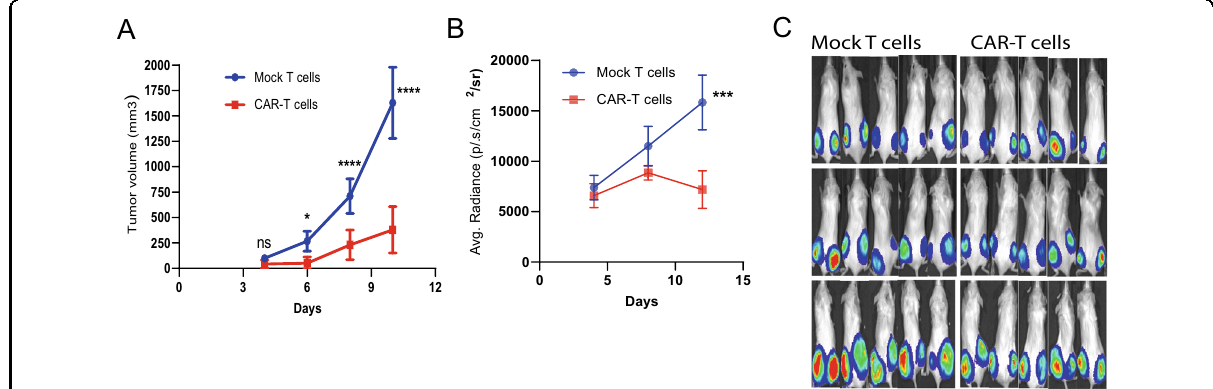
Fig. 5 CD126-targeted CAR-T cells demonstrated potent antitumor activity in murine models of multiple myeloma and prostate cancer. NSG mice were injected subcutaneously with RPMI-ultrachilli-luciferase cells and treated with a single dose of CAR-T cells or mock T cells. a Tumor volume was measured with calipers ( n = 10 each group). b Tumor burden ( D -luciferin BLI of RPMI-ultrachilli-luciferase) mice were quanti fi ed on days 4, 8, and 12. c Representative images from fi ve mice are shown from RPMI xenograft model. Mann – Whitney U non-parametric test. Two-way ANOVA and multiple comparison test. n.s. Not signi fi cant. * P < 0.05, *** P < 0.001, and **** P <